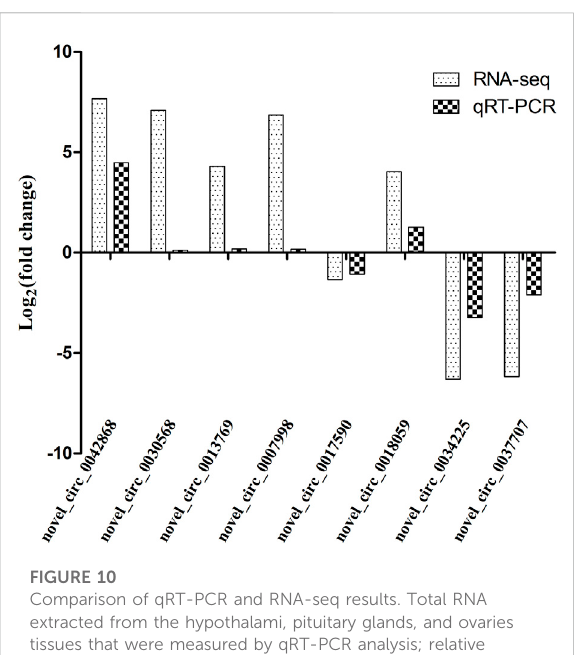
FIGURE 10 Comparison of qRT-PCR and RNA-seq results. Total RNA extracted from the hypothalami, pituitary glands, and ovaries tissues that were measured by qRT-PCR analysis; relative expression levels were calculated according to the 2 − ΔΔ Ct method using GAPDH as an internal reference